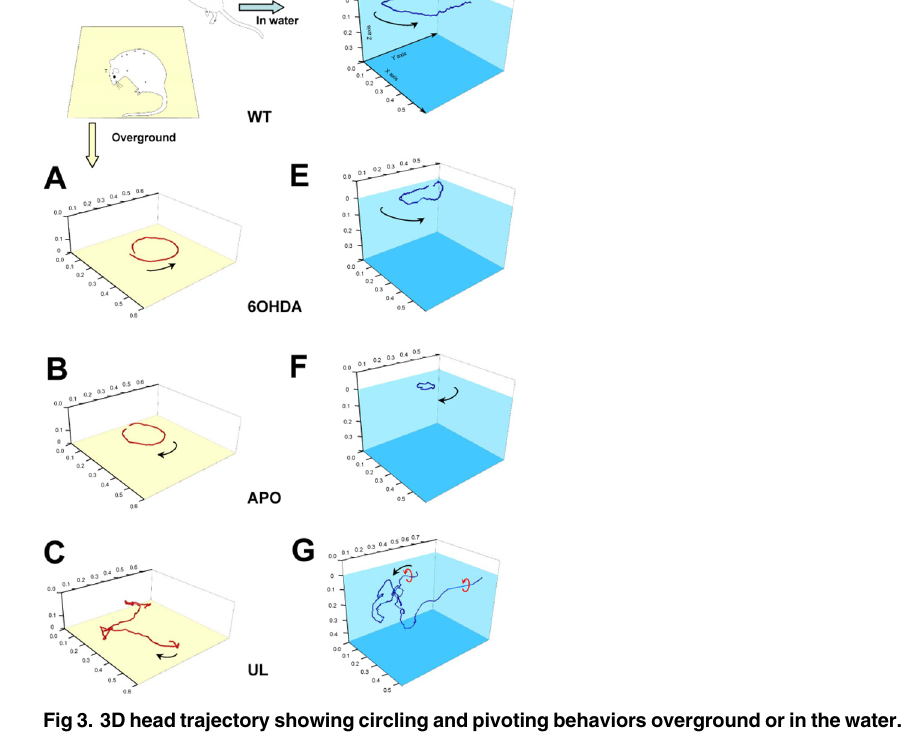
After apomorphine injection, the APO-rats placed on the platform exhibited pivoting behavior contraversive to the lesion ( Fig 3B ). The hindlimb ipsilateral to the lesion was not active, and rotated without having left from the ground, while the hindlimb contralateral to the lesion performed backward steps, and forelimbs acted forwardly and laterally. The footfalls of HLc, FLc, FLi, were as in 6-OHDA inside the trajectory of the head ( Fig 4B ). The diameter of the circle was not significantly smaller than 6-OHDA (but smaller than WT), however the